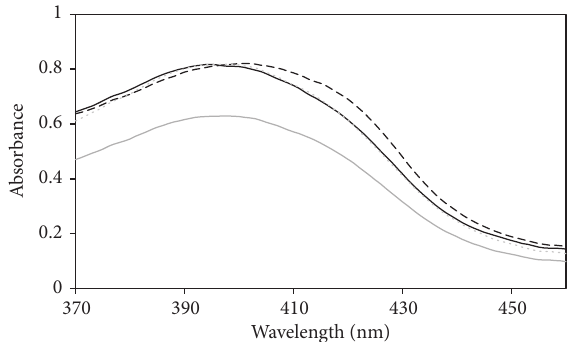
Figure 7: Absorption spectra of 9 𝜇 M CPO in 0.1M citrate-0.2 M phosphate buffer, pH 4.2 (solid line), in 11% v/v methanol and 0.1M citrate-0.2 M phosphate buffer, pH 4.2 (dashed line), dialyzed sample (grey solid line), and dialyzed sample adjusted for 1.3-fold volume increase (grey dotted